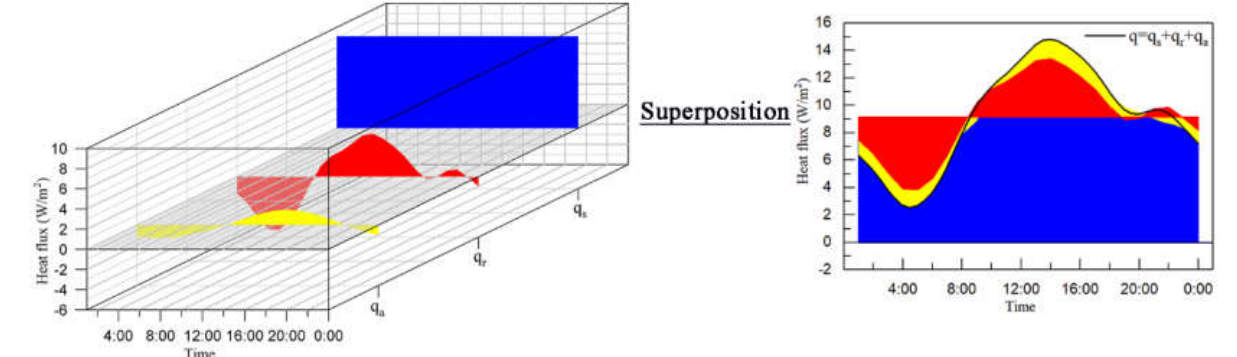
Figure 19. Heat transfer components and superposition of the external wall.